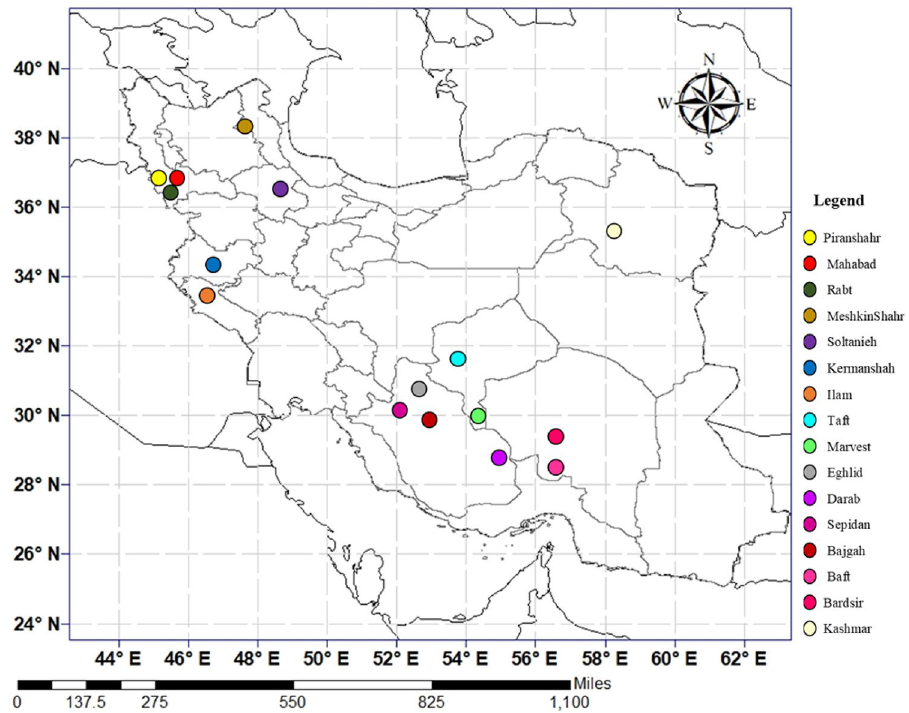
Figure 1. The collection areas for the investigated populations of G. glabra (the population’s codes are visible in Table 1 and this figure is created using ArcGIS 10.8; URL: https:// suppo rt. esri. com/ en/ produ cts/ deskt op/ arcgis- deskt op/ arcmap/